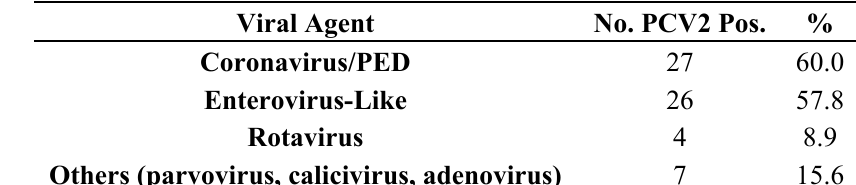
Table 2. Types of viruses observed by EM and the frequency of cases in association with PCV2. The percentages are calculated based on the total number of cases with multiple infections ( n =